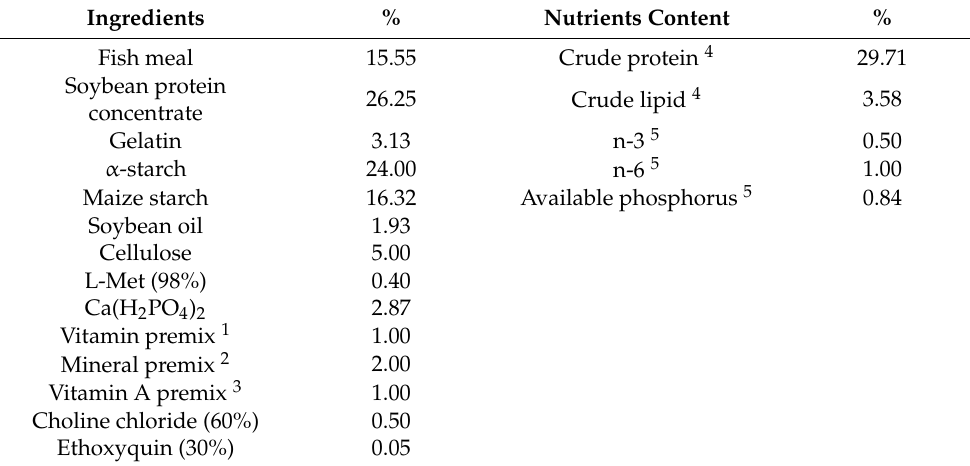
Table 1. Formulation and nutrient content of the basal